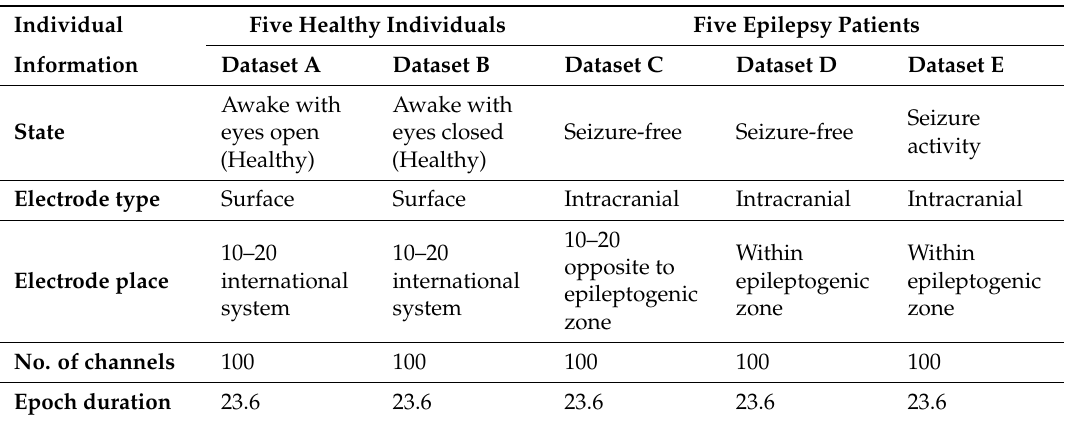
Table 1. The definitions and descriptions for the electroencephalographic (EEG) signals from the University of Bonn,